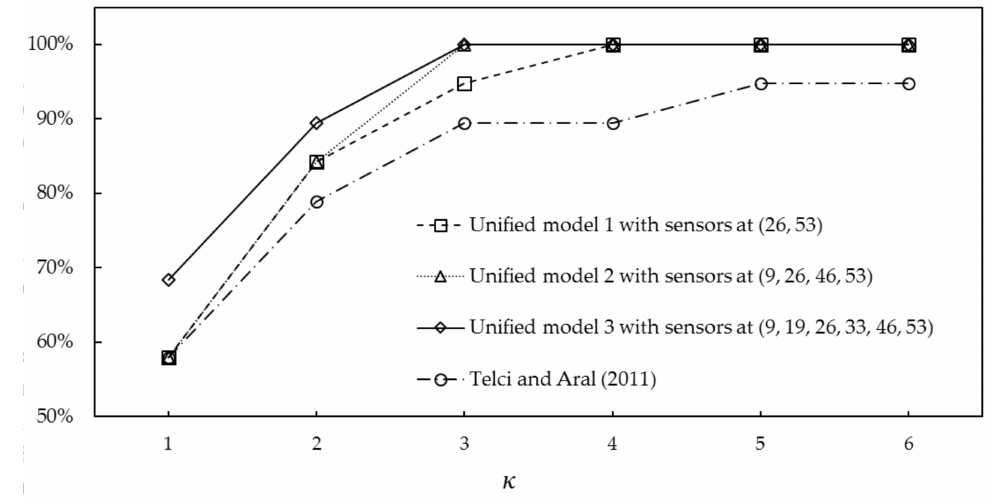
Figure 13. Percentage in which the correct spill location is included by the top κ with respect to P i ( d ) .